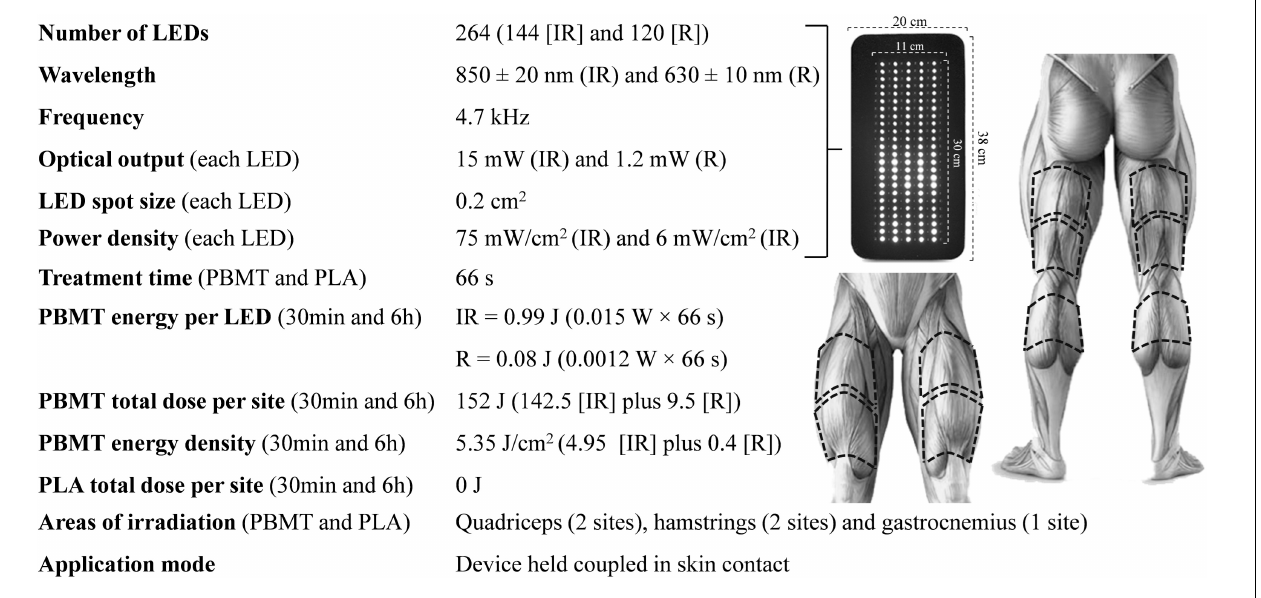
FIGURE 2 | Parameters of PBMT device and treatment. IR, infrared; R, red; PBMT 30 min , photobiomodulation applied 30 min before exercise; PLA 30 min , placebo treatment applied 30 min before exercise; PBMT 6 h , photobiomodulation applied 6 h before exercise; PLA 6 h , placebo treatment applied 6 h before